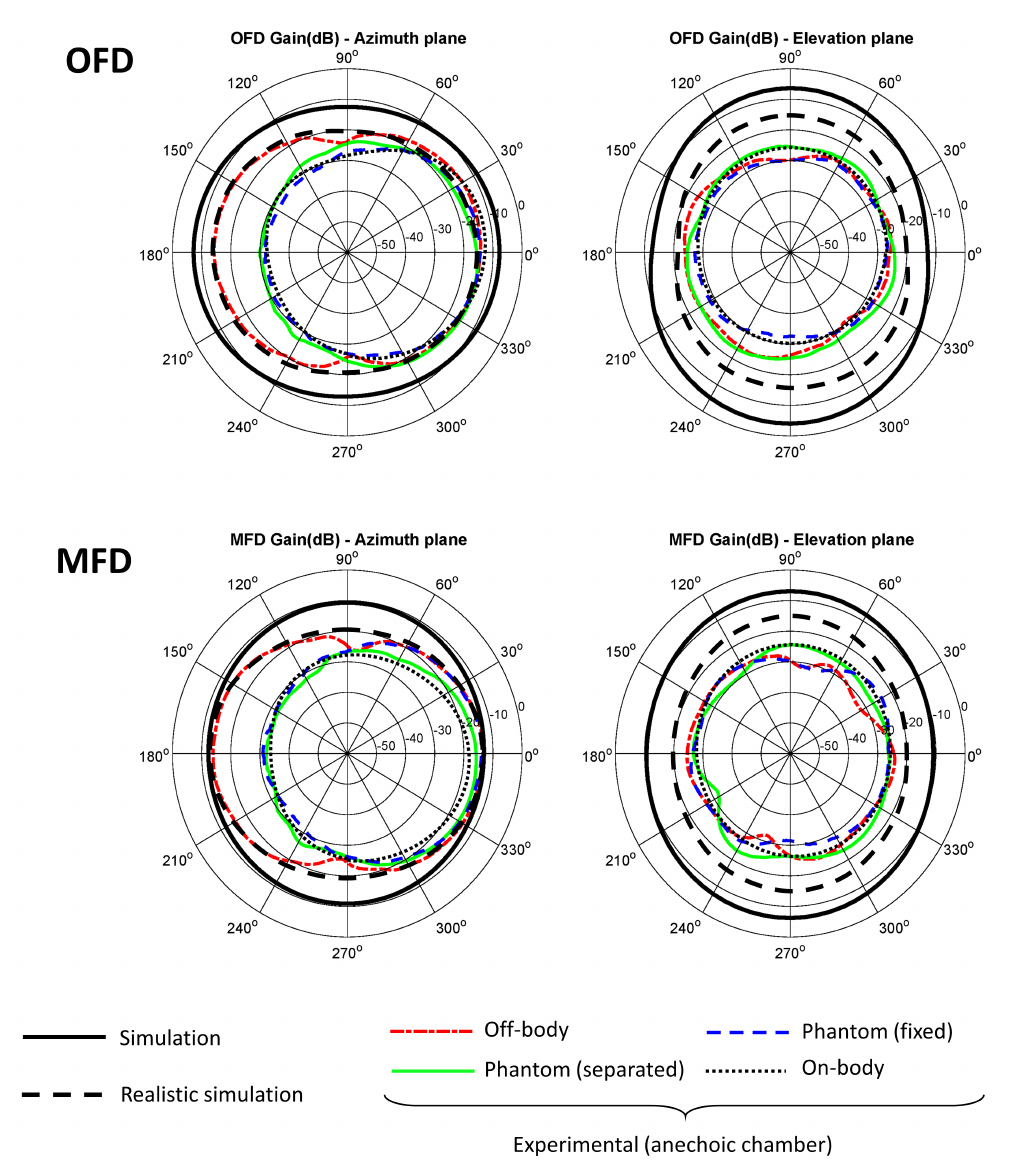
Figure 7. Simulated and experimental radiation patterns in azimuth and elevation planes of OFD and MFD